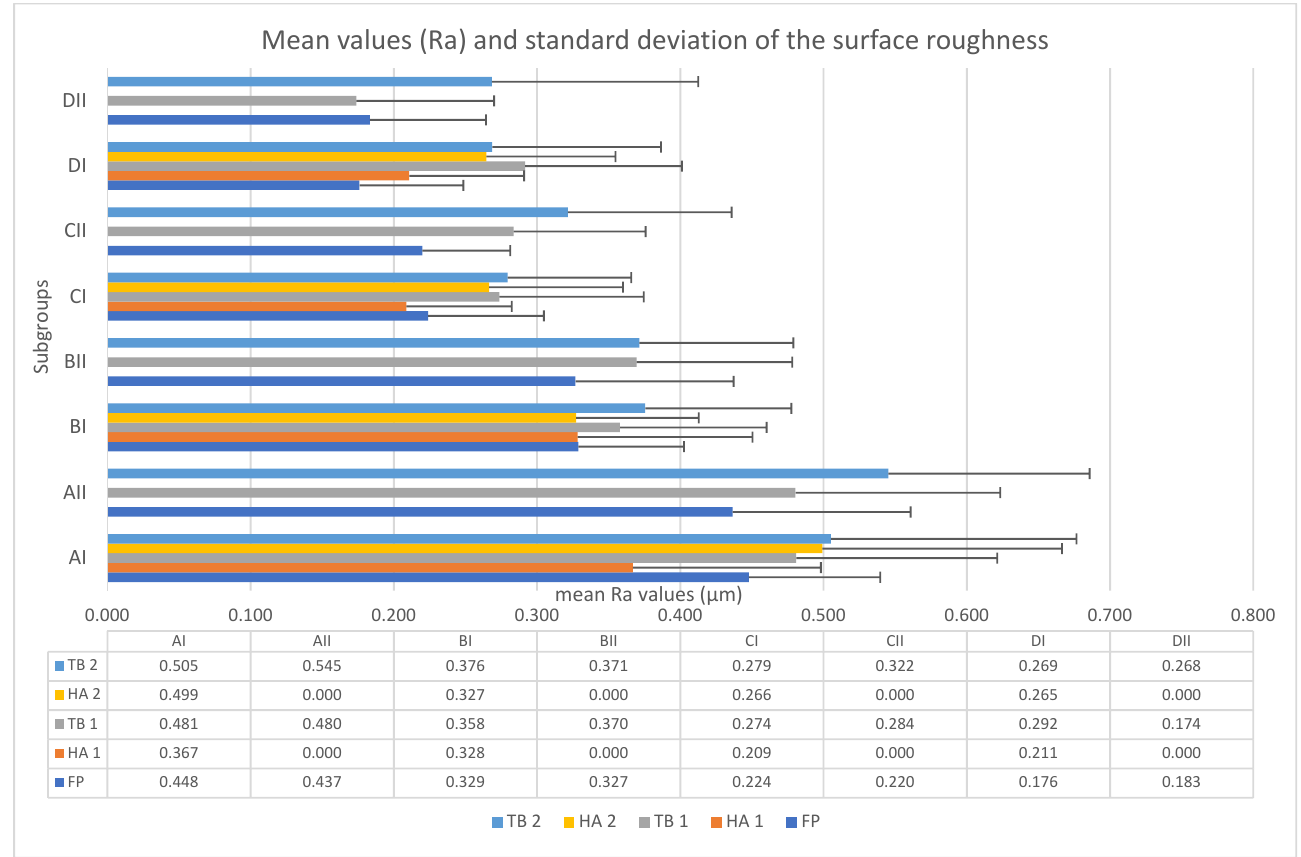
Figure 3. Boxplot representation of the mean (Ra) values and standard deviation of each subgroup in each stage.